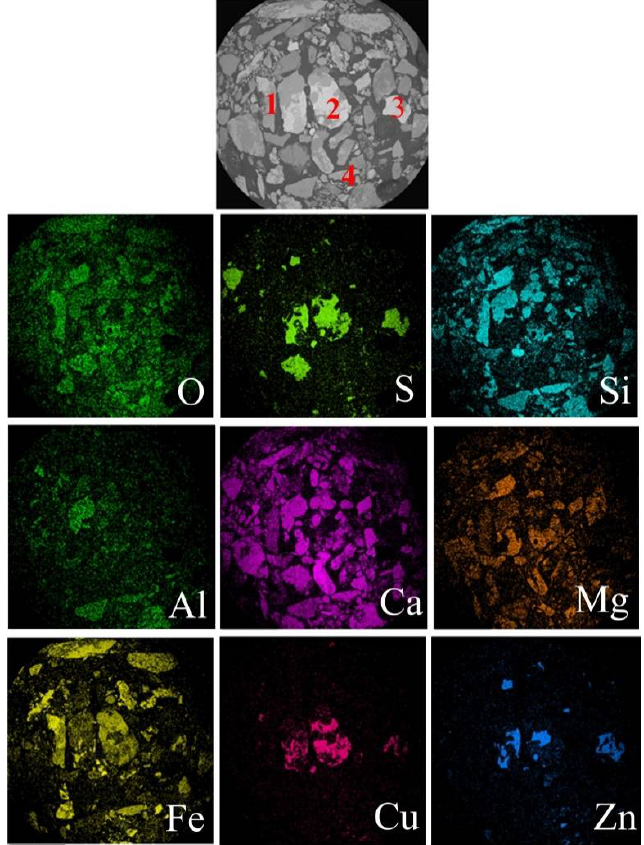
Figure 2. The SEM backscattered electron image and surface scan maps of main elements in the polymetallic ore (1—Iron oxide; 2,3—Copper-zinc sulphide; 4—Aluminosilicate). Table 3. Copper chemical phase analysis of the polymetallic ore (%). Table 4. Zinc chemical phase analysis of the polymetallic ore (%).